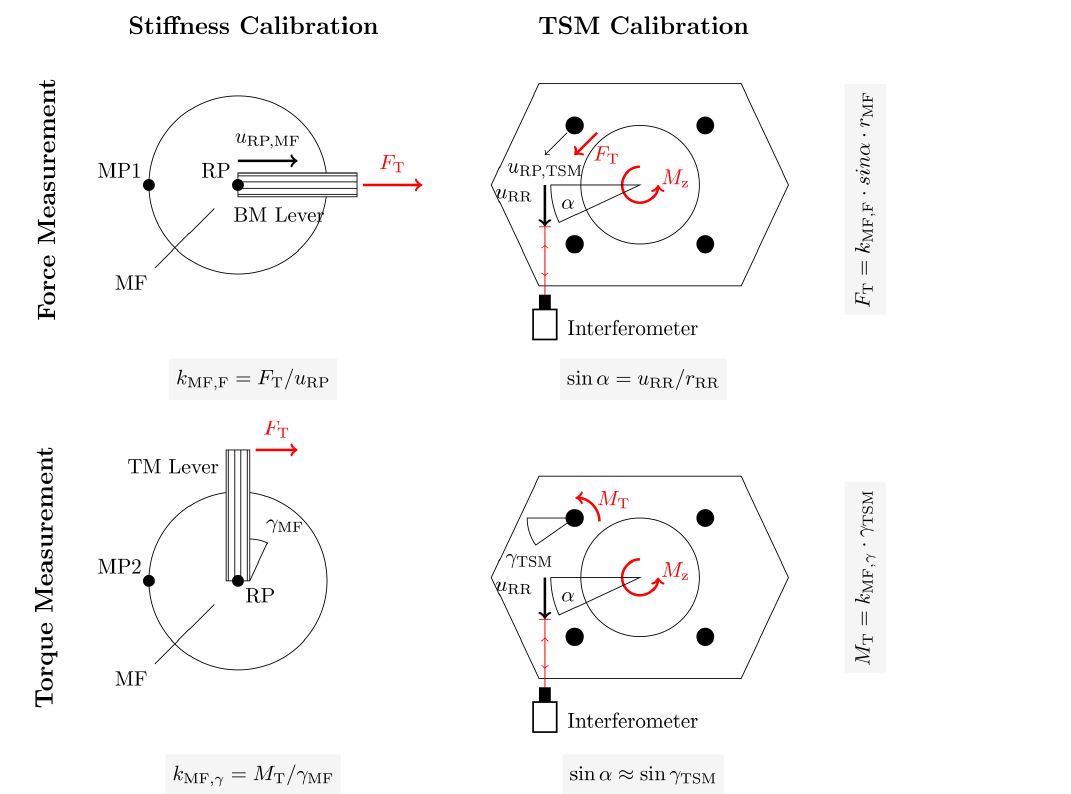
Figure 3. Measurement flexure working